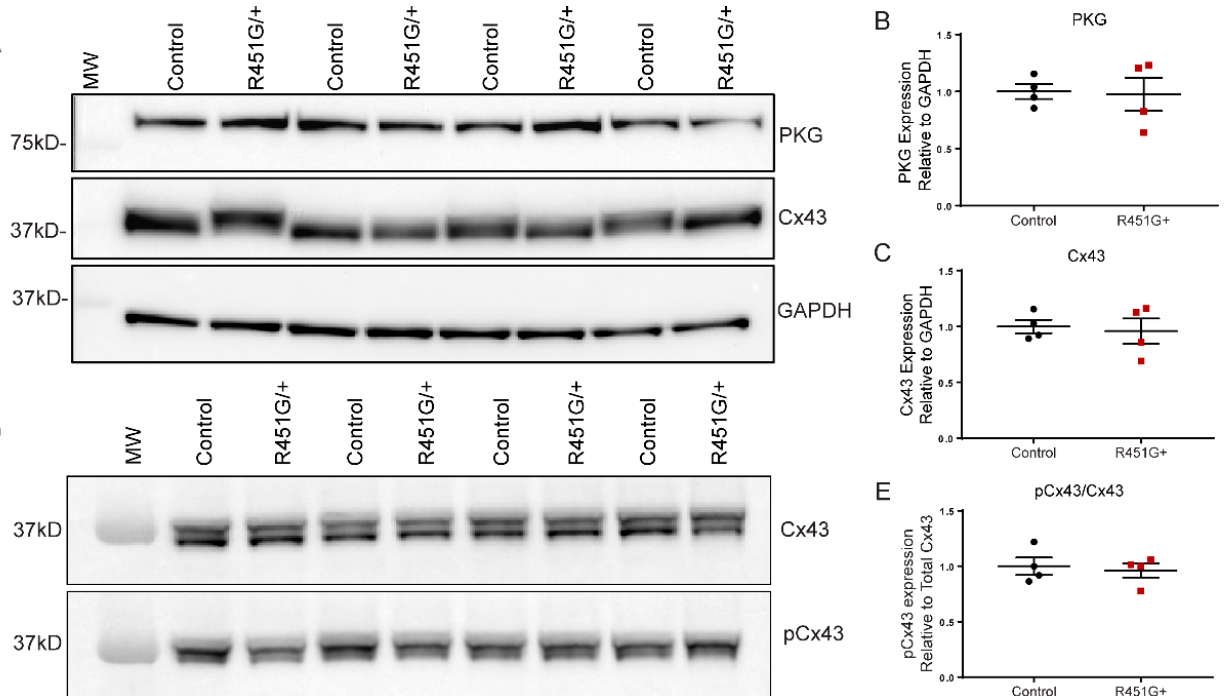
Figure 6. Dsp R451G/+ mice display no changes in expression of key ID proteins. ( A ) Immunoblots of heart lysates from Dsp R451G/+ mice and control littermates isolated at 3 months of age, evaluating key ID markers PKG and Cx43. ( B , C ) Quantification of PKG and Cx43 protein expression relative to GAPDH. ( D ) Immunoblots probing for pCx43 (Ser368) and Cx43. ( E ) Quantification of pCx43 pro-